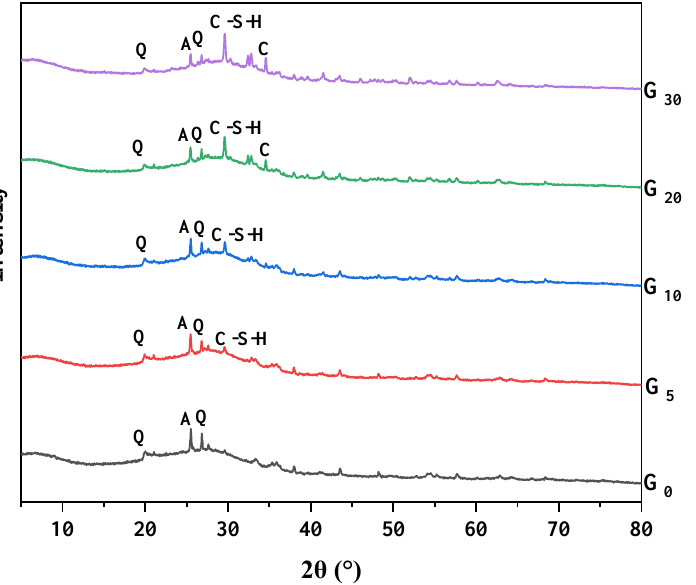
Figure 6. XRD patterns of the geopolymers containing 0% CEM I (G 0 ), 5% CEM I (G 5 ), 10% CEM I (G 10 ), 20% CEM I (G 20 ), and 30% CEM I (G 30 ). (A: anatase; Q: quartz; C: calcite; and C-S-H: hydrated calcium silicate).